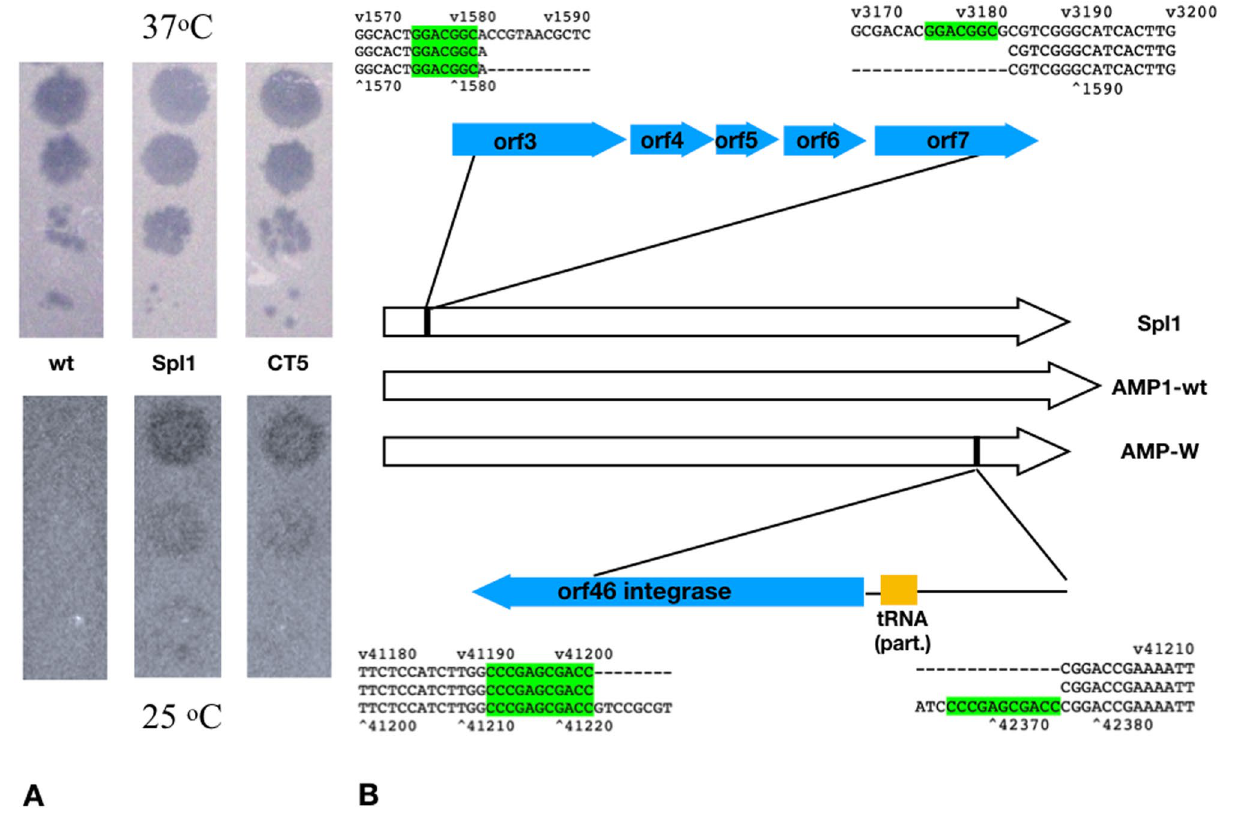
Figure 4. ( A ) Growth of the bacteriophage AMP1 wild-type (wt) strain and cold-tolerant mutant strains Spl1 and CT5 at 37 °C and 25 °C. ( B ) Schematic representation of the deletions that occurred in the bacteriophage strains AMP-W and Spl1. The short repeats flanking the deletions are highlighted in green.